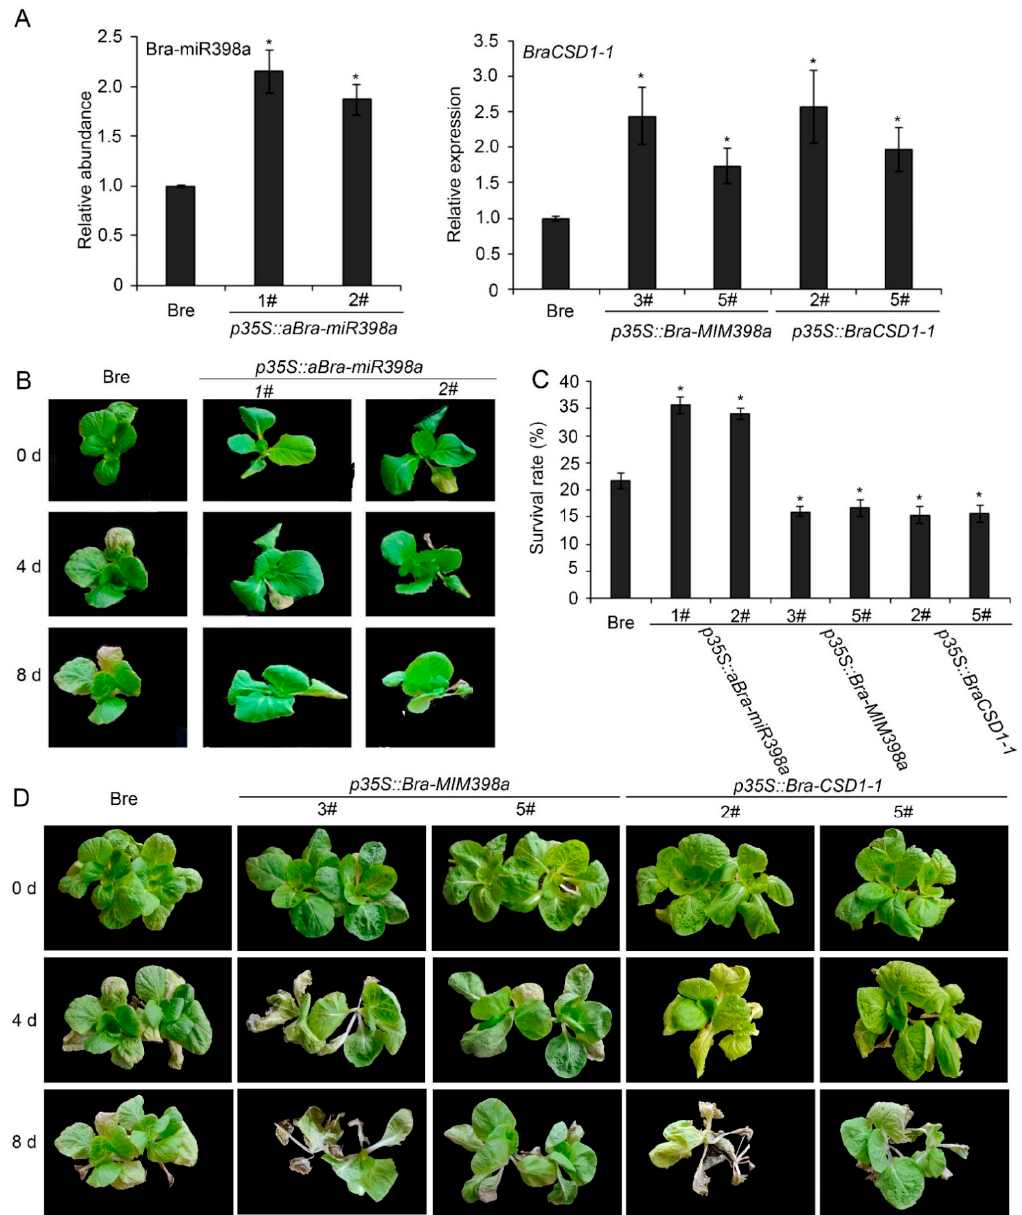
whitening area of leaves of the p35S::aBra-miR398a (1#, 2#) were smaller than that of the Bre (Figures 3B and 4).